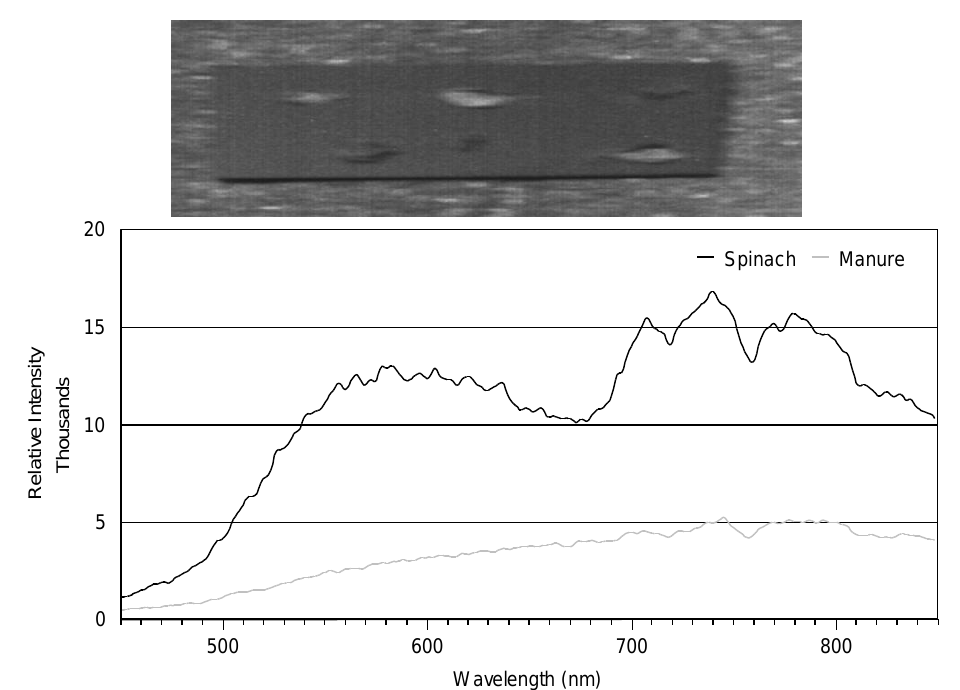
Figure 11. Reflectance image at 673 nm. The graph shows the representative spectra for spinach leaves and dairy manure.